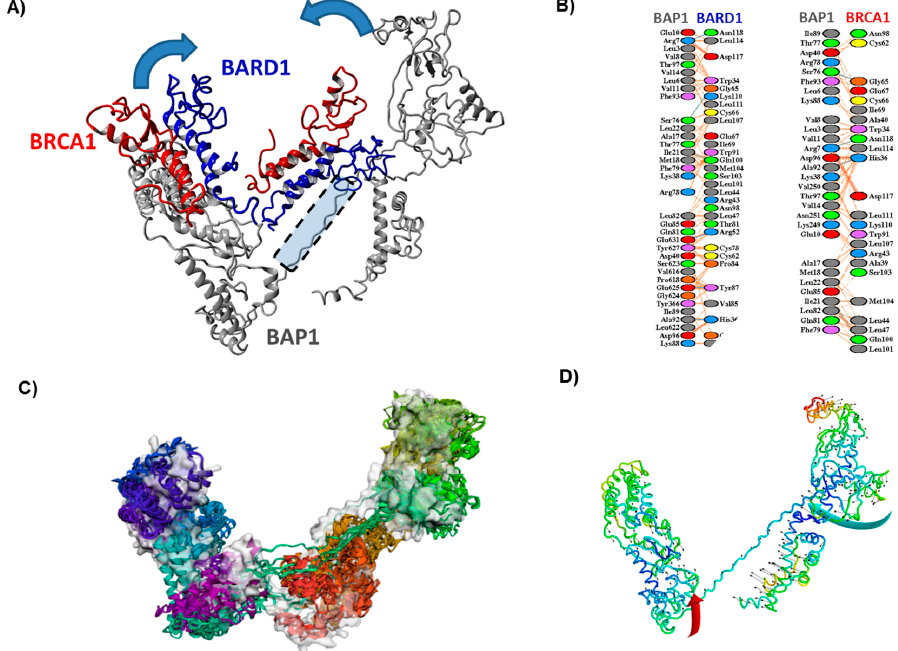
Figure 2. Conformational transition related to BAP1-BRCA-BARD1 complex. ( A ) The BAP1 structural model depicted with two select high scoring BRCA-BARD1 complex docking poses each docked with restraints specific to BRCA1 (left) and BARD1 (right). The structure is illustrated in ribbon format with BAP1 colored grey, while BRCA1 and BARD1 colored red and blue, respectively. The intervening disordered region that serves as a hinge for the conformational transition has been shaded and marked. The proposed movement of the N and C terminal regions of BAP1 has been shown with arrows ( B ) The inter-residue contacts between BAP1-BARD1 and BAP1-BRCA1 as observed in the two high scoring docking poses shown in ( A ), ( C ) and ( D ) The putative motion as observed from the output files of the CABS-Flex and iMODS server, respectively. Both BAP1 structures are depicted in ribbon format and colored domain-wise based on inter-region movement. In ( C ), the starting structure is also depicted by its surface area (grey colored). In ( D ), large arrows depict the movement of the domains in the perspective of the global fold of the protein, while small arrows depict subtle inter-domain movements.